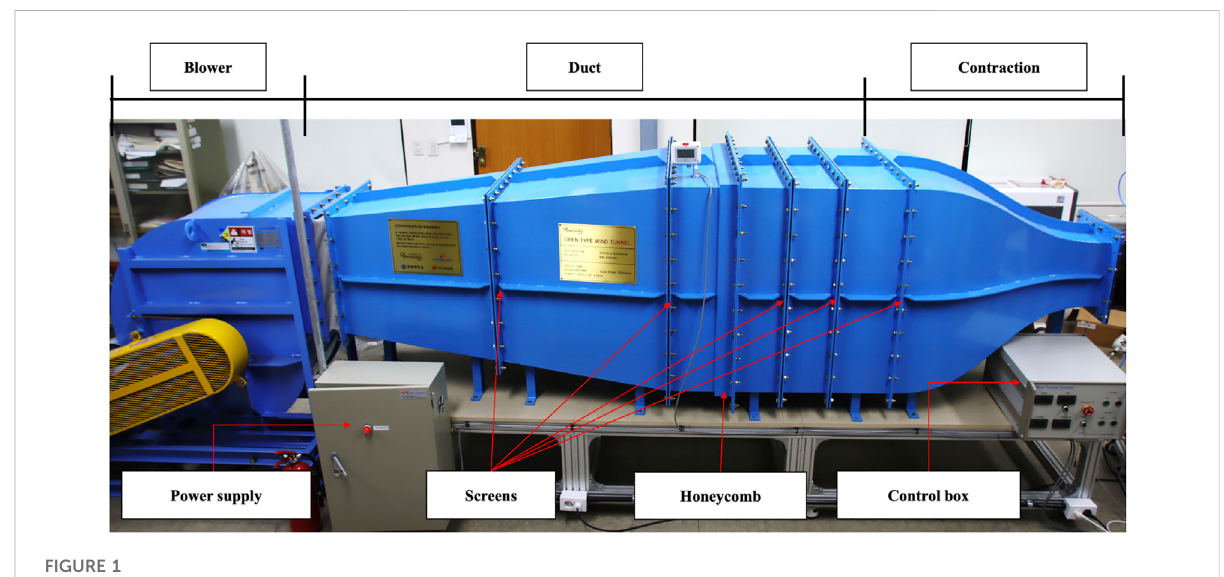
FIGURE 1 Experimental setup for main fl ow